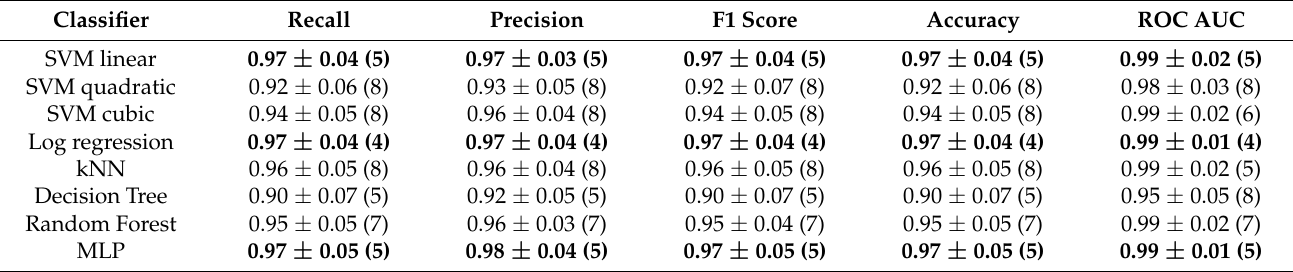
Table 3. Main classification performance measures obtained for a selected feature